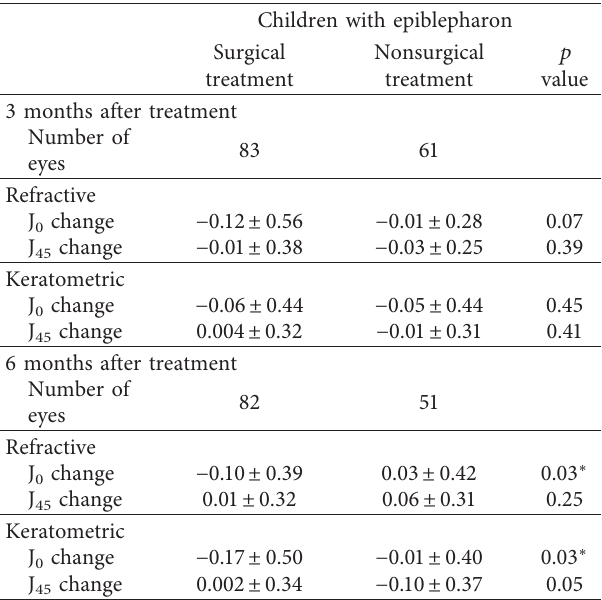
Table 4: Refractive and keratometric change of J Thibos and Horner’s power vector analysis at 3 and 6 months after